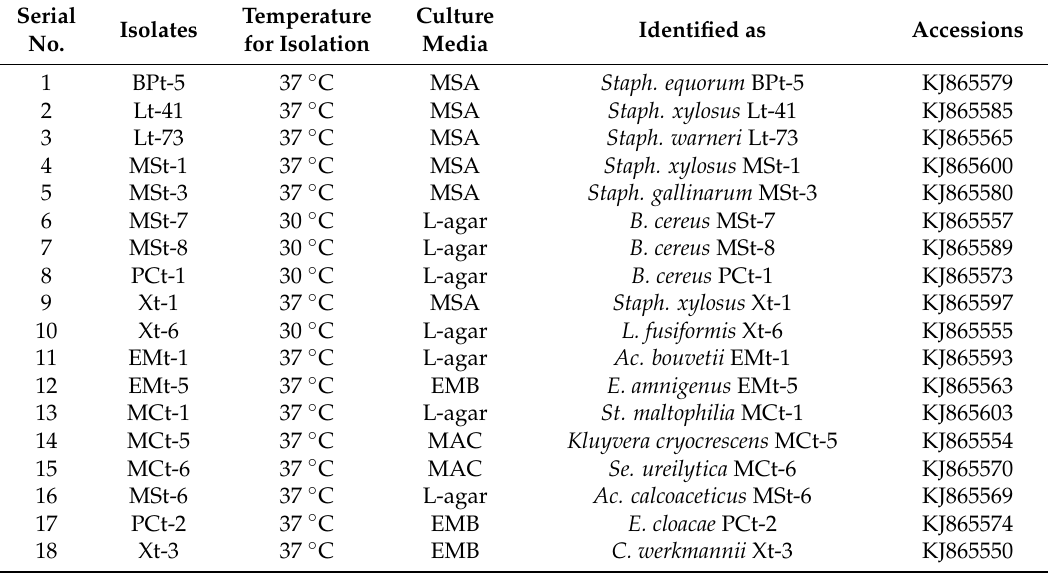
Table 3. 16S rRNA gene sequencing of bacteria isolated from turnip at different temperatures and in different culture